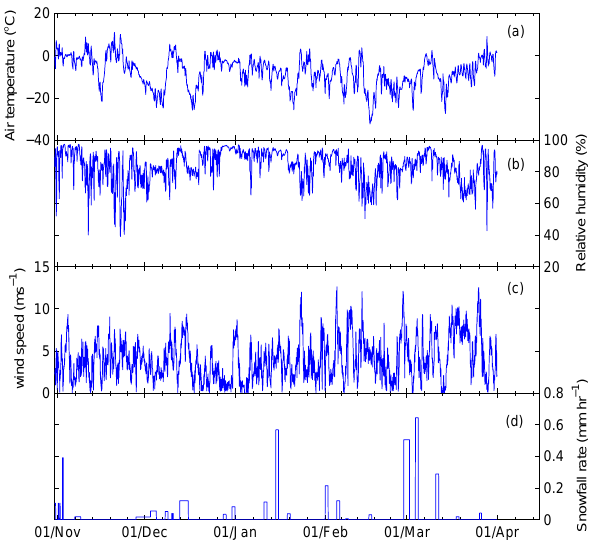
Fig. 1. Hourly observations of air temperature (a) , relative humidity with respect to ice (b) , wind speed (c) , and snowfall rate (d) from 31 October 2005 to 30 April 2006 over SDNWA, Saskatchewan, Canada.